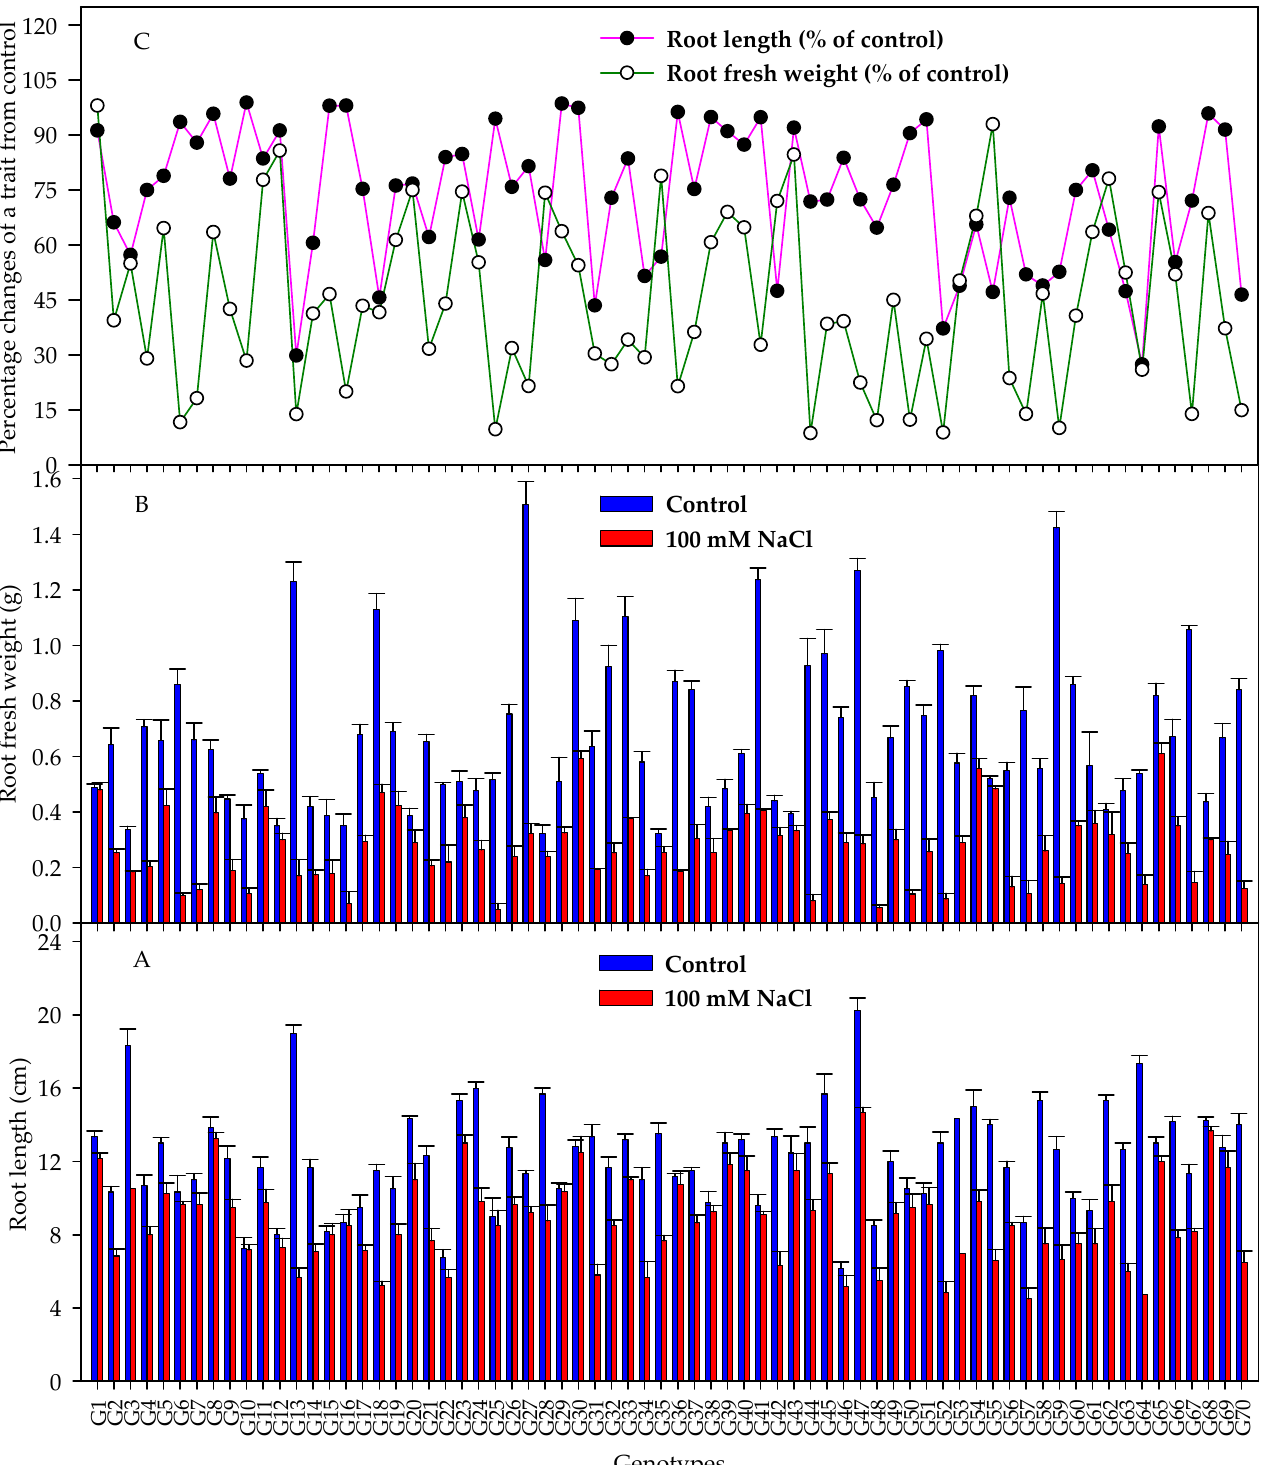
Figure 3. Root length ( A ), root fresh weight ( B ), and percentage changes of both traits from control ( C ) of 70 barley genotypes under control and 100 mM NaCl conditions. Values are means ± SE (n = 3). The full names of the different abbreviations of genotypes are listed in Table 1.